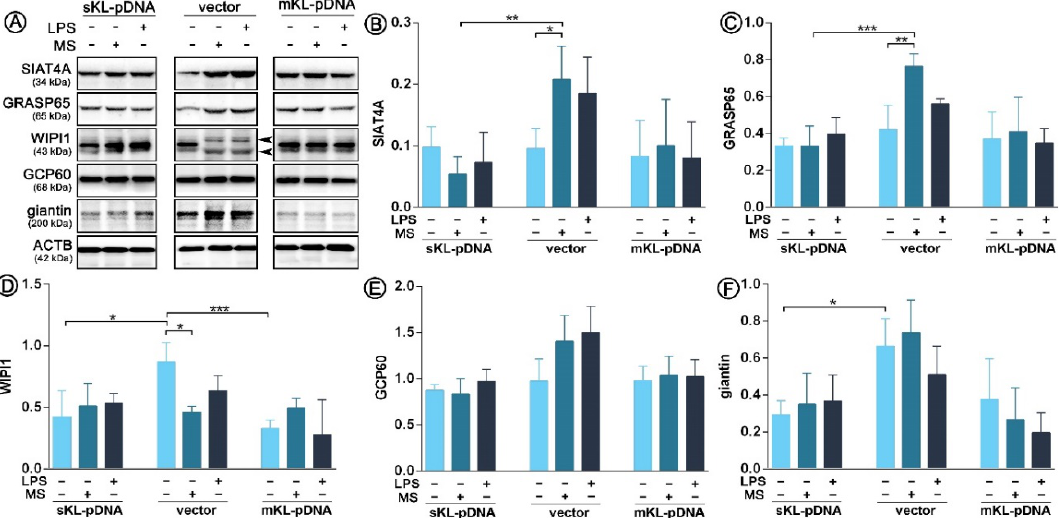
Figure 3. Expression of proteins involved in the Golgi-mediated stress response. Klotho expression was upregulated with pDNA, cells were treated for 72 h with monensin sodium or 168 h with LPS and the expression of TFE3-related proteins was evaluated with Western Blot method ( A ), i.e.,: SIAT4A ( B ), GRASP65 ( C ), WIPI1 ( D ), GCP60 ( E ), and giantin ( F ). The bands were quantified and normalized to their corresponding β -actin bands. Bars indicate SD, n = 3, *** p < 0.001, ** p < 0.01, * p < 0.05, no indication – no statistical significance (one-way ANOVA and Dunnett’s a posteriori test).